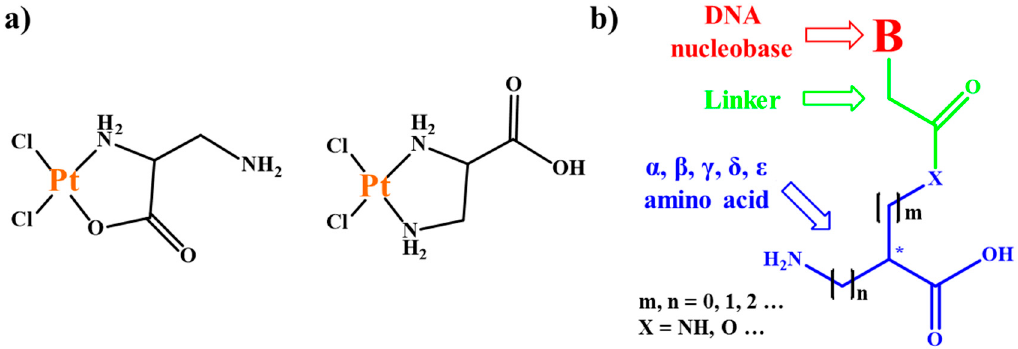
Figure 1. ( a ) Platinum complexes of L -2,3-diaminopropanoic acid (DAP-OH); ( b ) general structure of a nucleoamino acid.